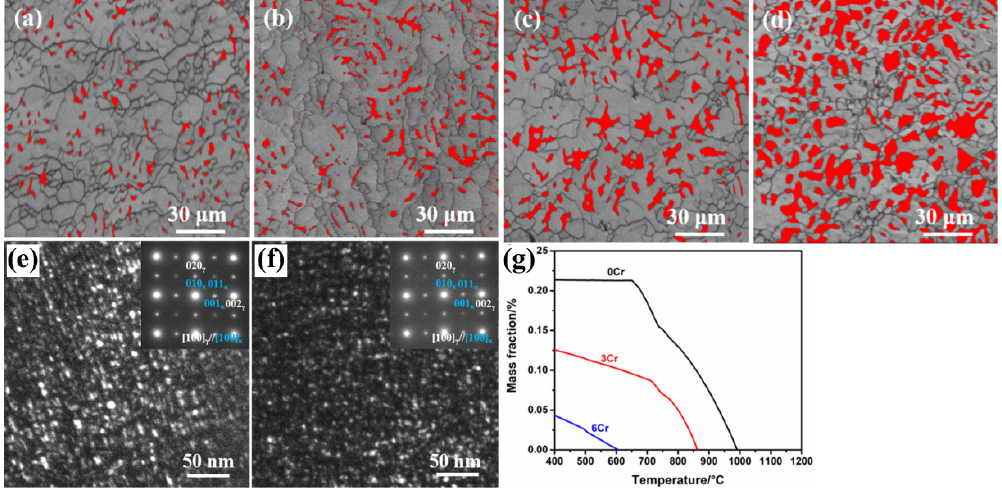
Figure 6. Electron backscattered diffraction (EBSD) phase maps of the as-cast Fe-20Mn-9Al-1.2C steels with different Cr content [164]: ( a ) 0Cr; ( b ) 3Cr; ( c ) 6Cr; and ( d ) 9Cr (red and gray contrasts indicate δ -ferrite and γ -austenite phases, respectively). TEM DF images of κ ’-carbides of the aged steels with ( e ) 0Cr and ( f ) 3Cr contents and ( g ) the thermodynamic calculation showing the variation in the mass fraction of κ ’-carbides different Cr content. (Reproduced with permission from [164]. Copyright 2022